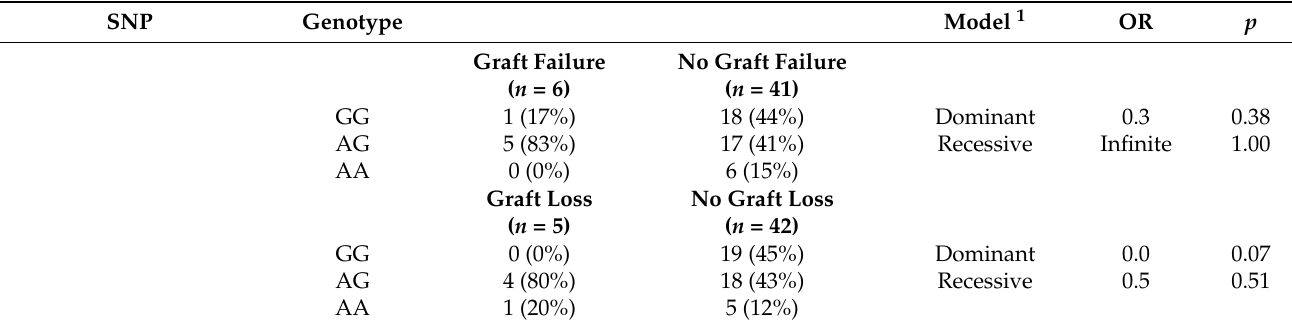
Data were analyzed by Fisher’s exact test, using either a dominant or recessive model. 1 Test conditions: allele A (major allele) vs. allele B (minor allele); AA vs. AB plus BB (dominant model); AA plus AB vs. BB (recessive